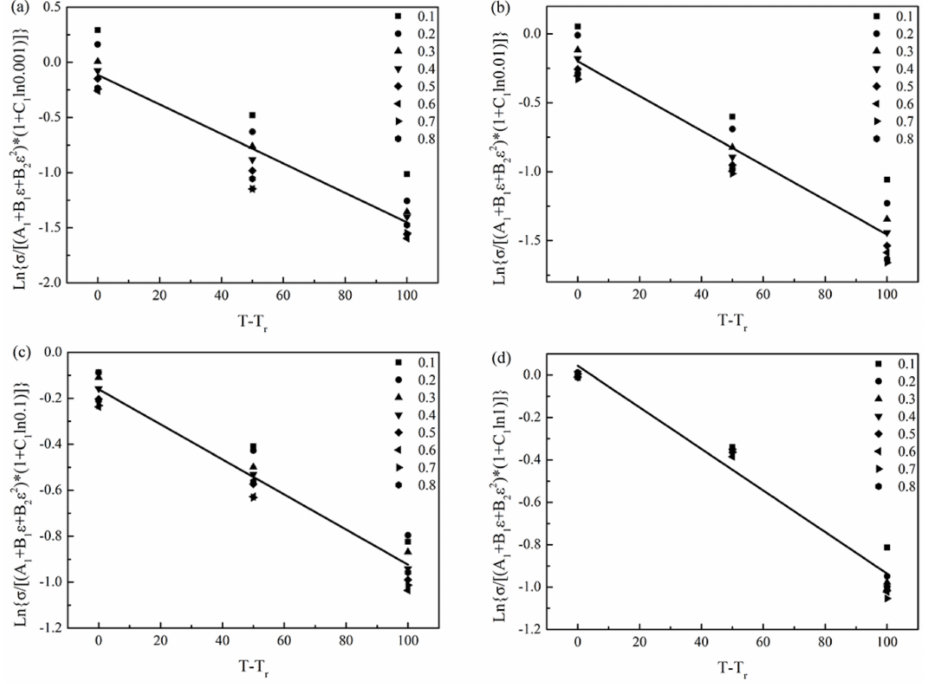
. ε ∗ )} and ( T − Tr ) at different strain